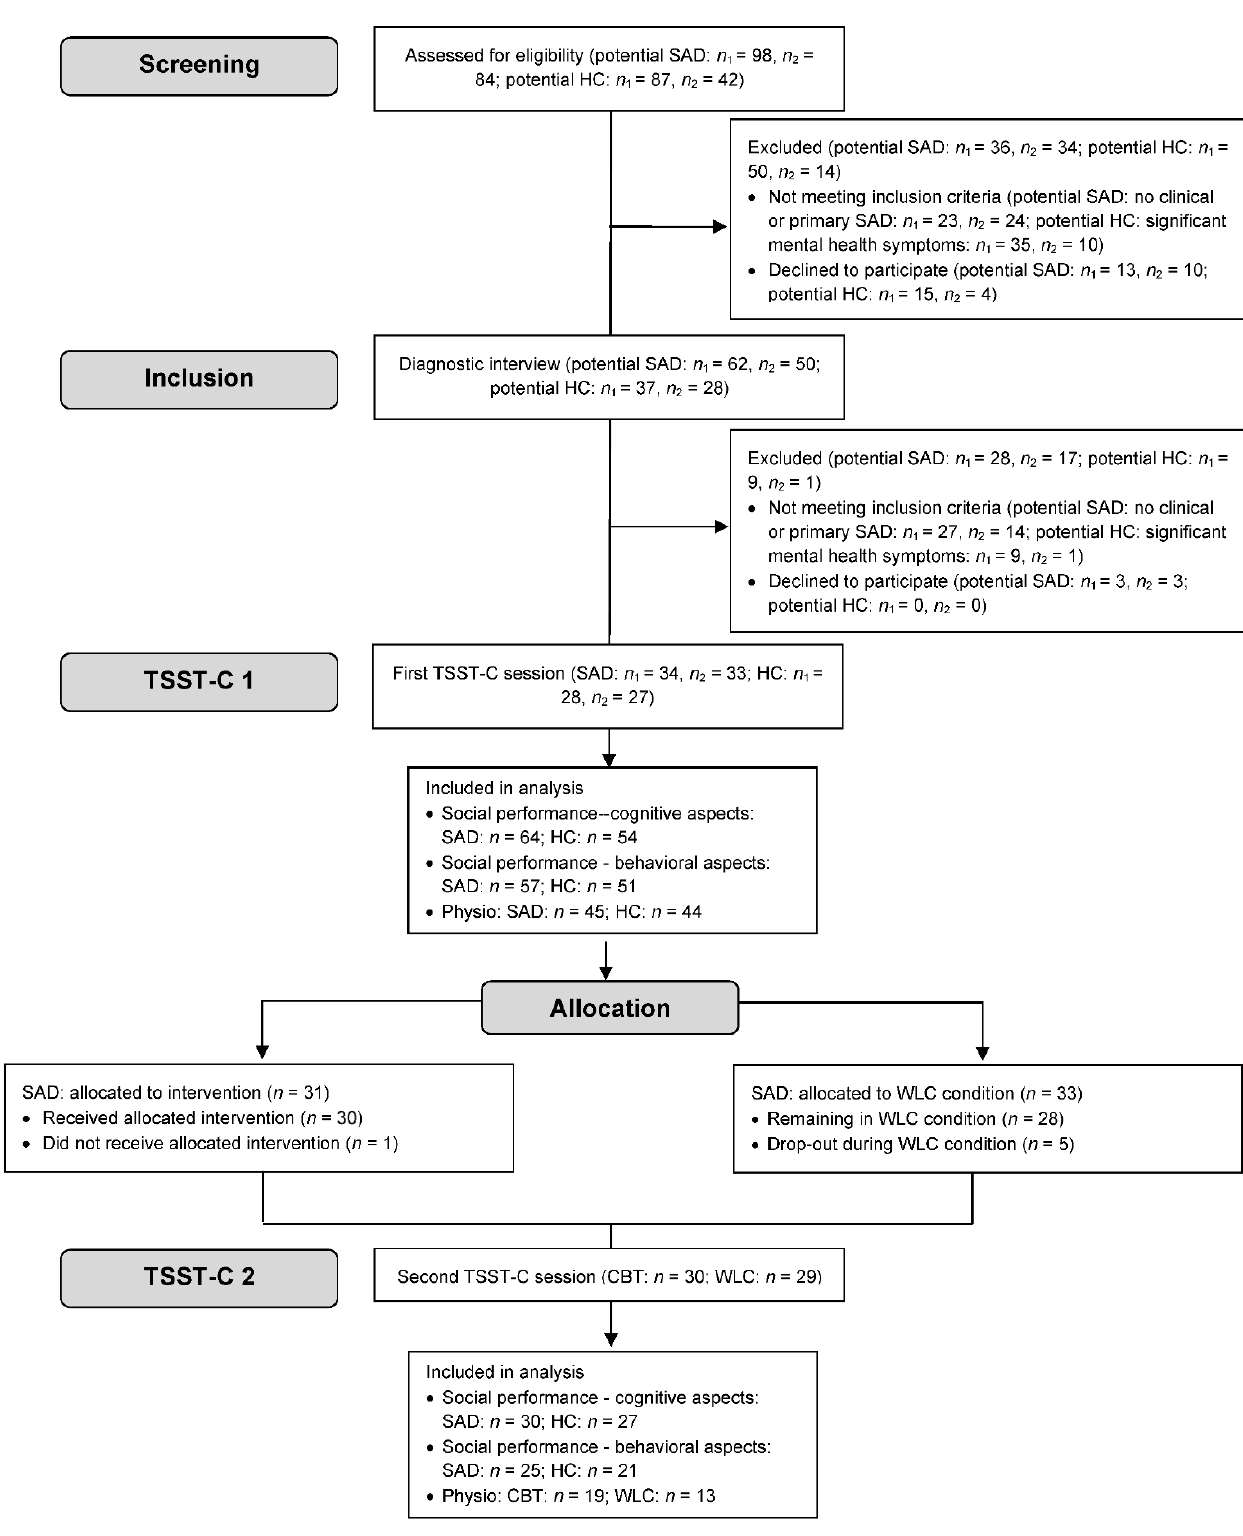
Figure 1. Flowchart of study participants. Note: missing data were mostly based on technical difficulties, that is, no video/audio recording. n 1 = Center 1, n 2 = Center 2; CBT = cognitive behavior therapy; HC = healthy control; SAD = social anxiety disorder; TSST-C = Trier Social Stress Test for Children; WLC = wait-list control.